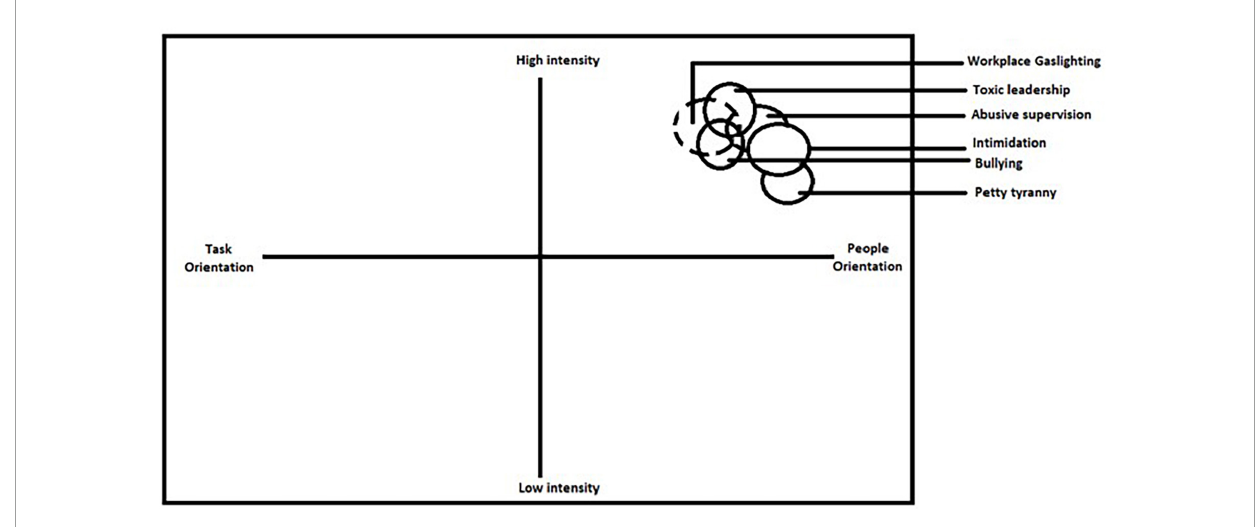
FIGURE2 Gaslighting in the typology of harmful leader behaviors (Almeida et al.,